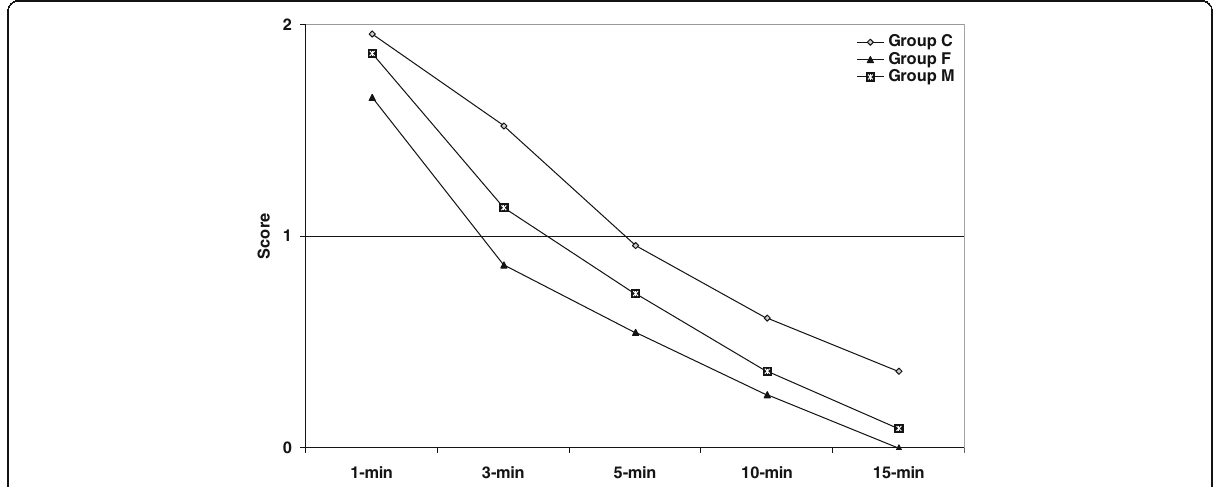
Fig. 2 Mean scoring of globe akinesia recorded in patients of studied group throughout 15 min after LAM